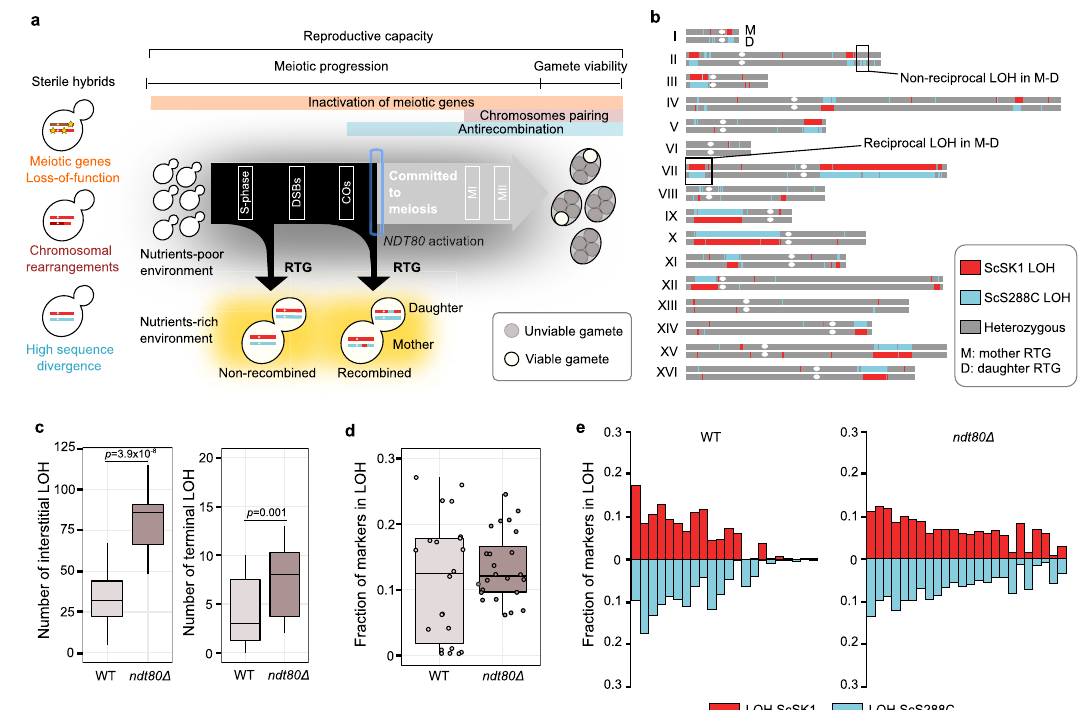
Fig. 1 RTG paradigm and genomic landscape of ndt80 Δ evolved RTG clones. a Inactivation of essential meiotic genes (yellow stars), genomic rearrangements and high levels of heterozygosity in hybrid genomes can impair meiotic progression or reduce gamete viability. RTG represents an alternative route to hybrid evolution that creates LOH regions. b LOH map in a mother/daughter (top/bottom, respectively) RTG pair derived from the ndt80 Δ hybrid. LOH blocks can be tracked by genotyping single-nucleotide markers which give a homozygote readout. c Boxplots of the number of interstitial (left) and terminal (right) LOH events in the wild-type (WT, n = 22) and ndt80 Δ ( n = 24) RTG clones derived from ScS288C/ScSK1. The ndt80 Δ RTGs have more interstitial ( p value = 3.9 × 10 − 8 ) and terminal ( p value = 0.001) LOHs. Both tests are one-tailed Wilcoxon rank-sum tests with continuity correction. Testing only the mother cells in both data sets ( n = 12 ndt80 Δ , n = 11 WT) con fi rmed that ndt80 Δ mothers accumulated more interstitial ( p value = 5.033 × 10 − 8 ) and terminal ( p value = 0.0053) LOHs, using one-tailed Wilcoxon rank-sum test with continuity correction. No parental bias was detected by comparing the average number of LOHs towards one of the two subgenomes in WT (Welch ’ s t test two-tailed, p value = 0.67) and ndt80 Δ data sets (Welch ’ s t test two-tailed, p value = 0.25). d Boxplot reporting the fraction of markers in LOH. Each point represents an RTG sample. The distribution of the WT samples ( n = 22) is broader and shows a larger interquartile range compared with the ndt80 Δ data set ( n = 24). e Fraction of homozygous markers for both parental alleles for the WT and ndt80 Δ data sets. Each bar represents a sequenced clone. The ndt80 Δ RTGs show a lower variation compared with the wild-type, both considering a pooled data set ( n = 24) (Fligner-Killeen test two-tailed, p value = 0.0008) and considering only the mothers from each data sets (Fligner-Killeen test two-tailed, p value = 0.02). The boxplot is de fi ned as follows: the box is delimited by the fi rst quartile (Q1) and the third quartile (Q3). The line that separates the box is the median. Whiskers are de fi ned as: upper whisker = min(max(x), Q3 + 1.5 × IQR); lower whisker = max(min(x), Q1 – 1.5 × IQR), where: x is the data, Q1 is the fi rst quartile, Q3 is the third quartile and IQR is the interquartile range (IQR = Q3 –